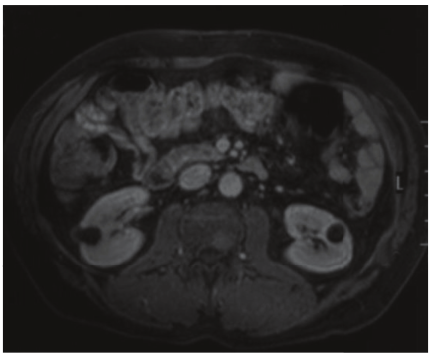
Figure 3: Abdominal MRI on T1-weighted axial imaging revealed a 1cmwideheterogeneousmetastaticlesionattheleftsideofposterior L2 and L3 vertebrae corpus.